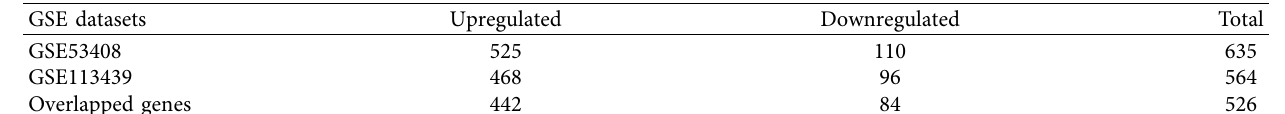
Figure 2: Volcano plots, cluster heatmaps, and Venn diagram of DEGs for GSE53408 and GSE113439 datasets. (a) Volcano plots of GSE53408 and GSE113439 datasets. Red dots represent upregulated genes based on adjusted P value < 0.05 and log2FC ≥ 1. Blue dots represent downregulated genes based on adjusted P value < 0.05 and log2FC ≤ − 1. The black points represent genes with no significant difference. FC is the fold change. (b) Cluster heatmaps of the top 100 significant genes of GSE53408 and GSE113439 data. Red indicates that the gene expression is upregulated, blue indicates that the gene expression is downregulated, and white indicates no significant changes in gene expression. Abbreviations: DEGs, differentially expressed genes. (c) Venn diagram of DEGs, left panel: the upregulated overlapping DEGs in the two datasets are 442; right panel: the downregulated overlapping DEGs in the two datasets are 84. Table 2: Number of differentially expressed